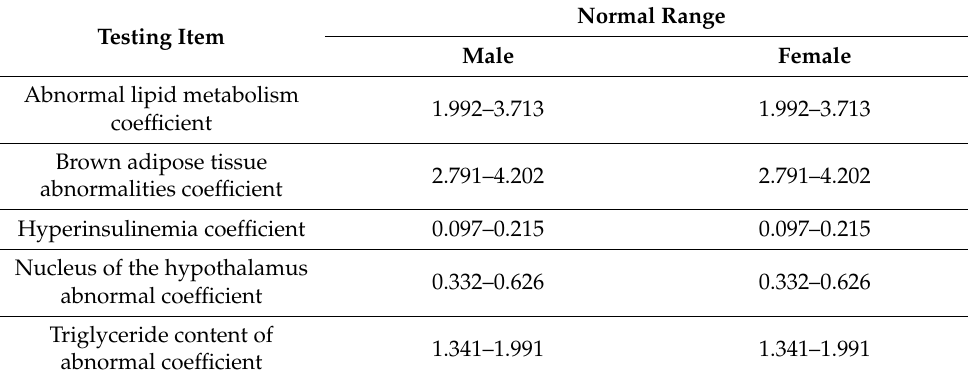
Table 1. Reference values of the obesity analysis report.